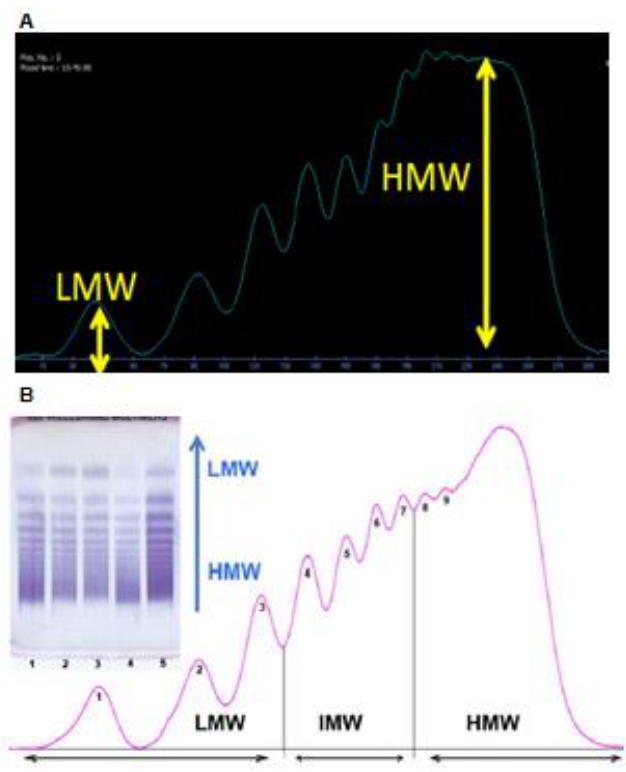
Figure 1. Densitometric representation of VWF multimers. ( A ) Peak intensity directly correlates with VWF multimer concentration. ( B ) Densitometric representation of peaks from left to right, with peaks 1–3 being LMW, peaks 4–7 being IMW, and all other peaks forming HMW (own data).